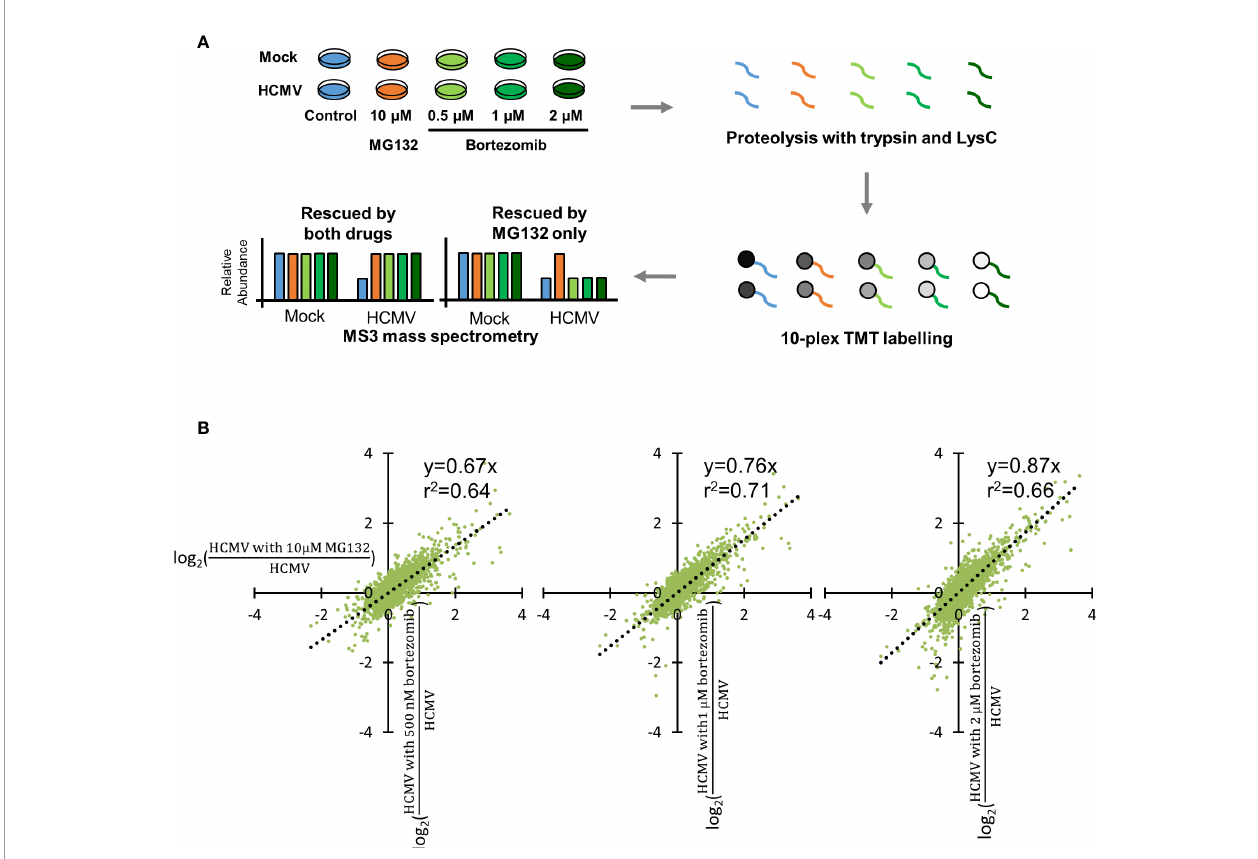
FIGURE 1 | Optimization of bortezomib concentration by comparison with 10 µM MG132. (A) Schematic of the experimental work fl ow. HFFF-TERT cells were infected with Merlin strain HCMV (MOI 5) or mock infected and simultaneously treated with 10 µM MG132, 500 nM, 1 µM, or 2 µM bortezomib. Samples were harvested at 12 hpi to maximize the ability to study very early infection as we previously described (Nightingale et al., 2018). Whole cell lysates were digested into peptides, which were labelled with TMT reagents followed by MS3 mass spectrometry. (B) Comparison of 10 µM MG132 with 500 nM, 1 µM, or 2 µM bortezomib during HCMV infection. Each dot represents a protein quanti fi ed in the experiment. The x-axis shows the fold change of protein abundance +/- 10 µM MG132 during HCMV infection. The y-axis shows the fold change of protein abundance +/- 500 nM, 1 µM, or 2 µM bortezomib during HCMV infection. The equations and correlation coef fi cients of the linear trend lines are